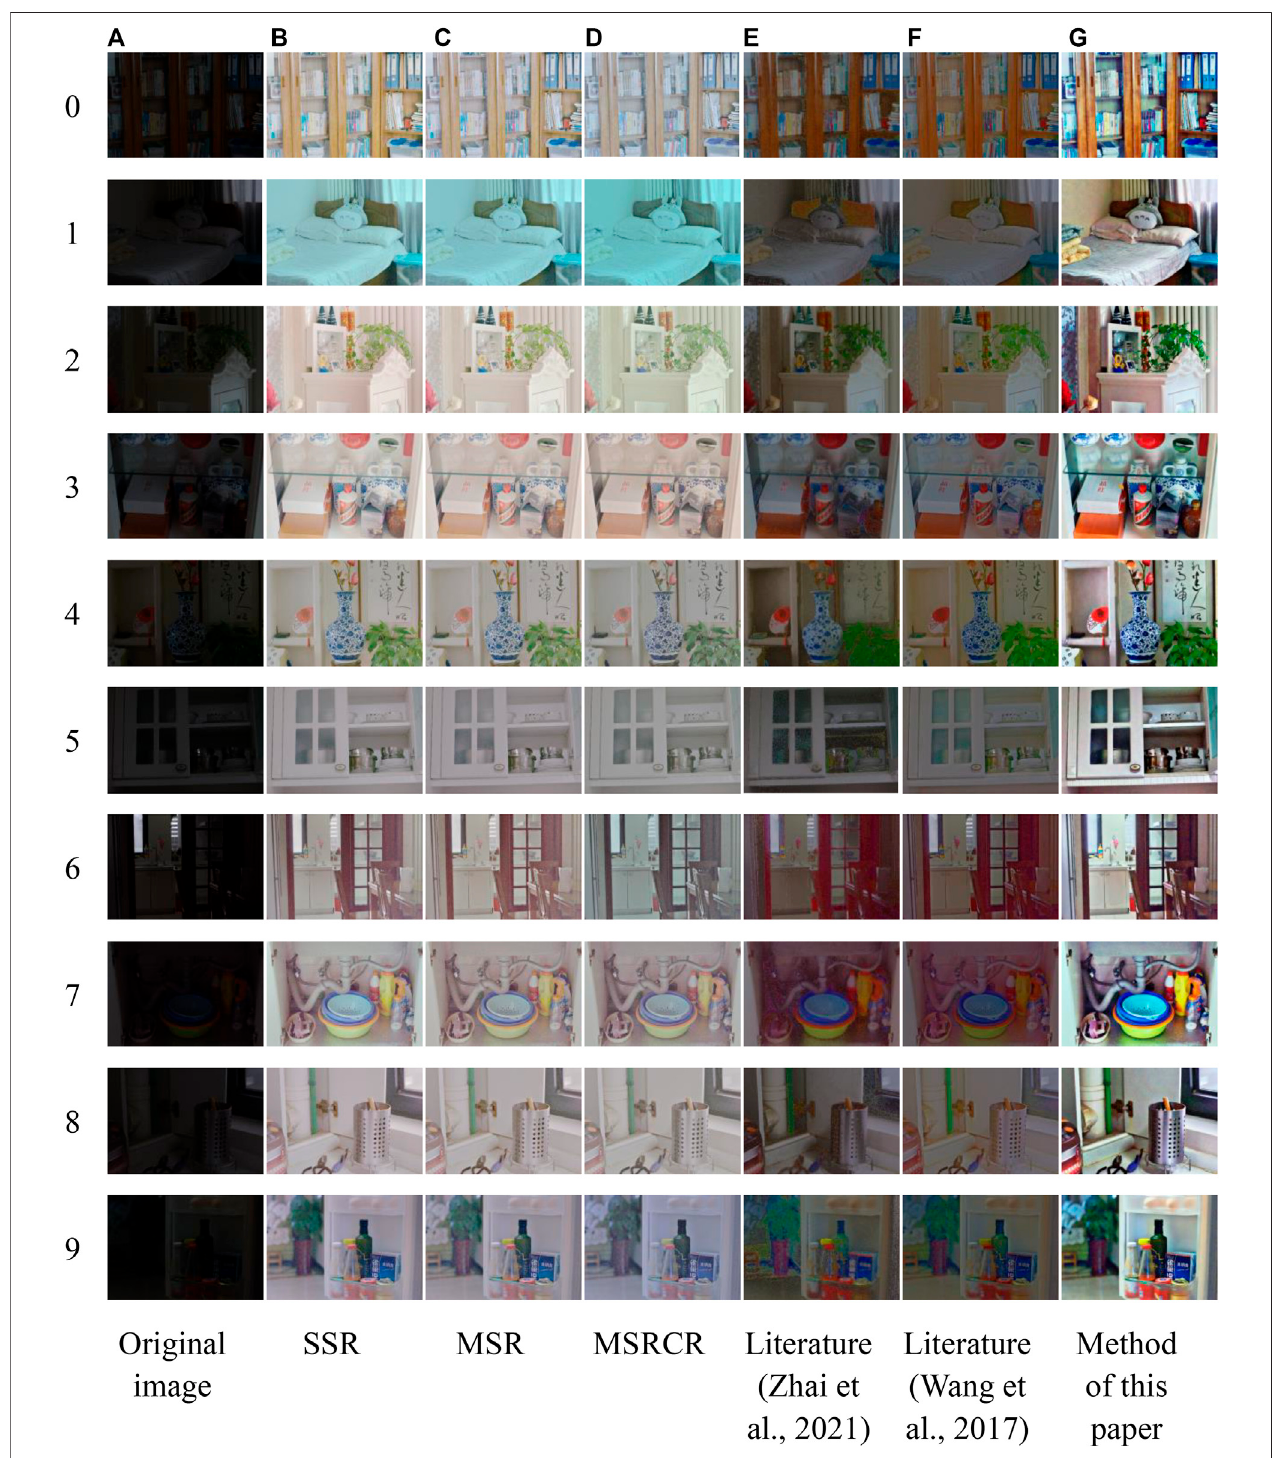
FIGURE10| Low-illuminationimageprocessingresultsunderdifferentalgorithms. (A) Originalimage (B) SSR (C) MSR (D) MSRCR (E) Literature(Zhaietal.,2021) (F) Literature (Wang et al., 2017) (G) Method of this paper.